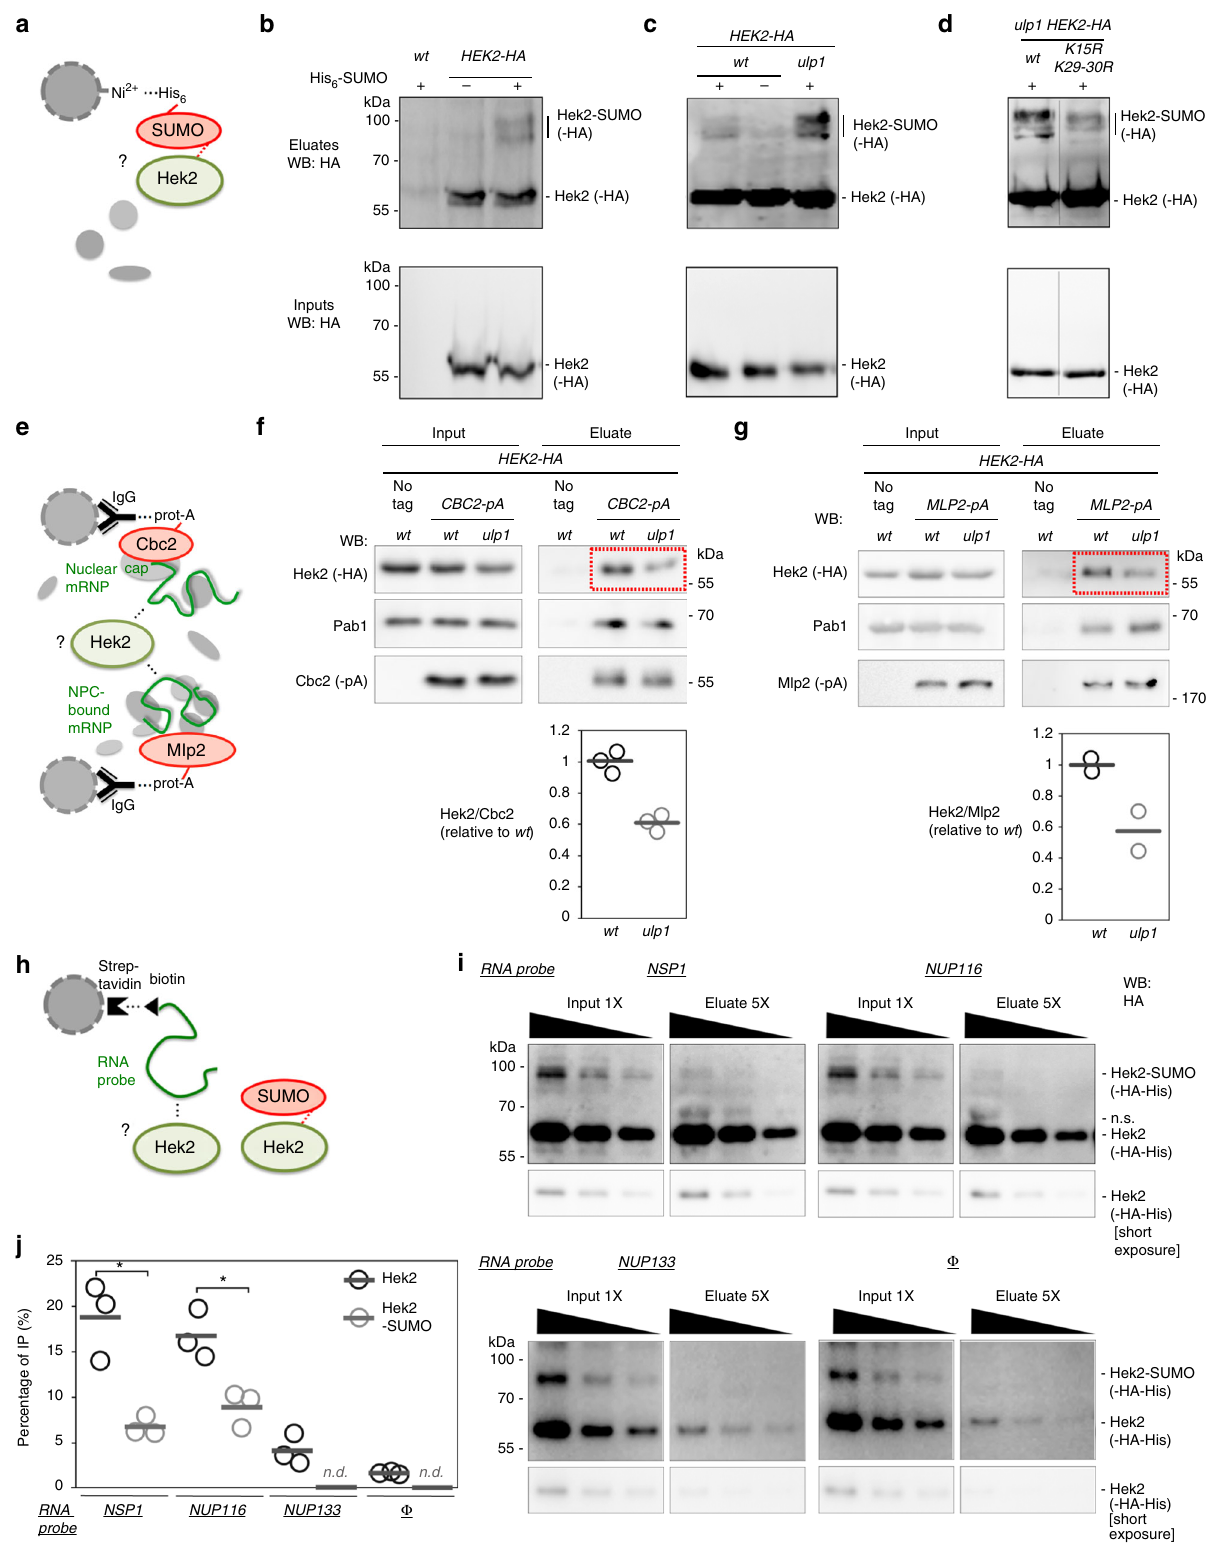
To answer this question, cellular SUMO conjugates were puri fi ed by denaturing Ni 2 + chromatography from strains expressing a poly-histidine-tagged version of SUMO and the hemagglutinin (HA)-tagged version of Hek2 (Fig. 3a). This assay speci fi cally detected slower-migrating species of Hek2 in